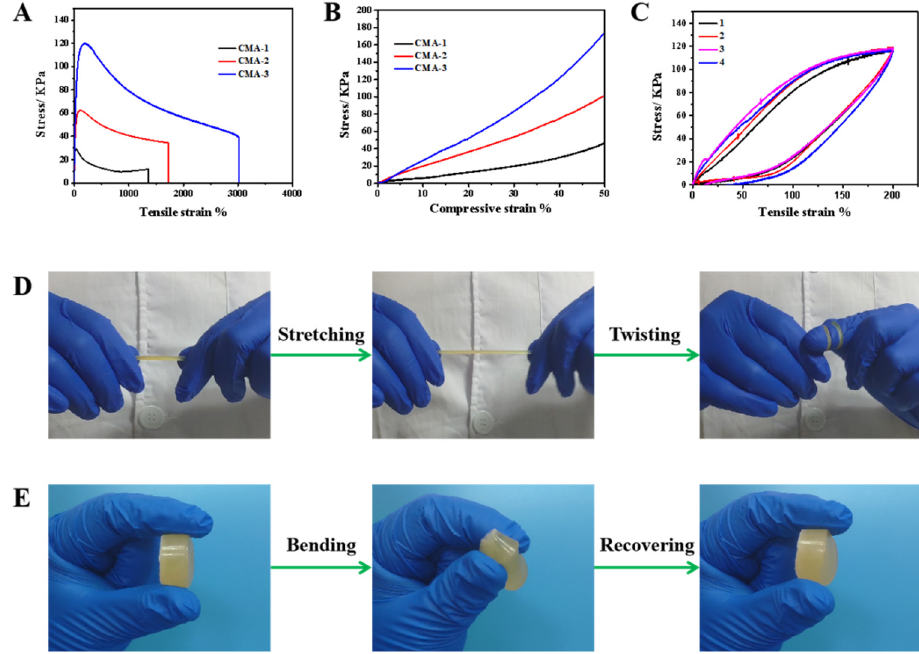
Figure 2. Mechanical properties of CMA hydrogels: ( A ) Tensile strain curve at 10 mm min − 1 . ( B ) Compressive strain curve at 5 mm min − 1 . ( C ) Stretching–releasing cycles. Photographs of CMA-3 hydrogel exhibiting excellent stretching and bending flexibility ( D , E ).